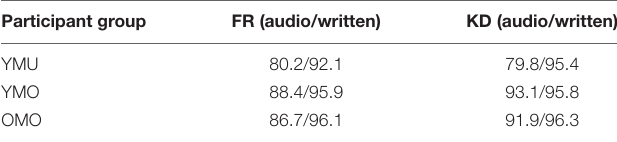
TABLE 3 | Average correctness scores (in %) of audio and written stimuli calculated over the whole experiment separated by participant group and context condition (French Accent vs. Kiezdeutsch).